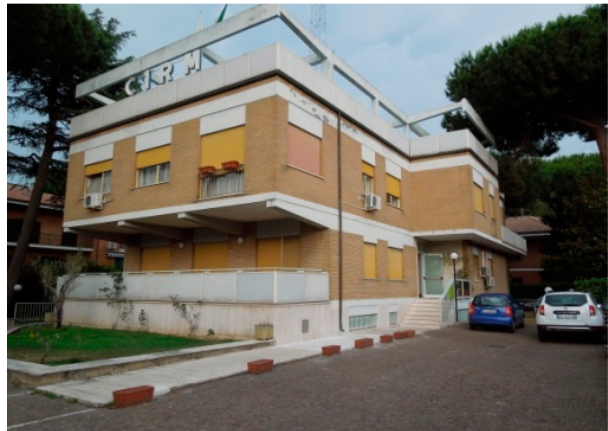
Figure 3. The International Radio Medical Centre (CIRM) administrative headquarter building.